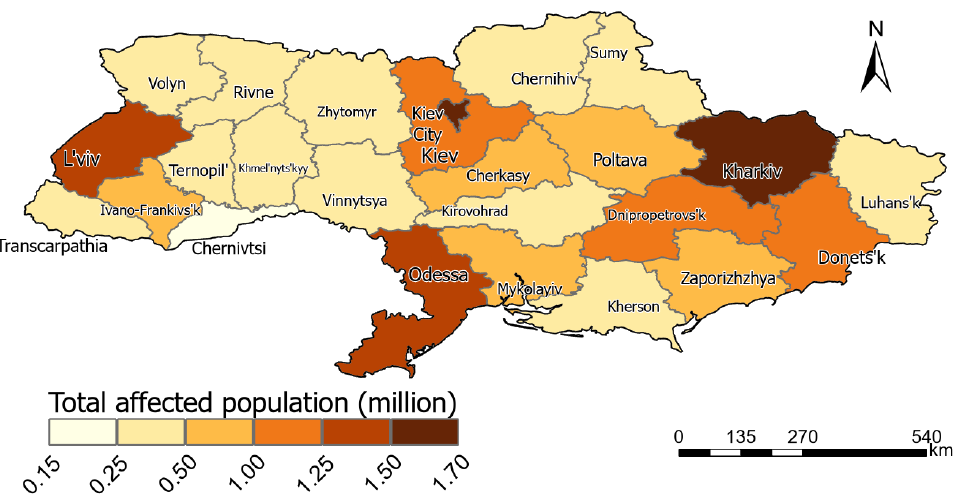
Figure 6. The estimated population within the Ukrainian oblasts affected by the power shortages triggered by the Ukrainian-Russian conflict. Specifically, the affected population for each oblast was estimated by summing up the LandScan HD layer pixel values for the deep blue (dramatically decreased) areas in Figure 5a.